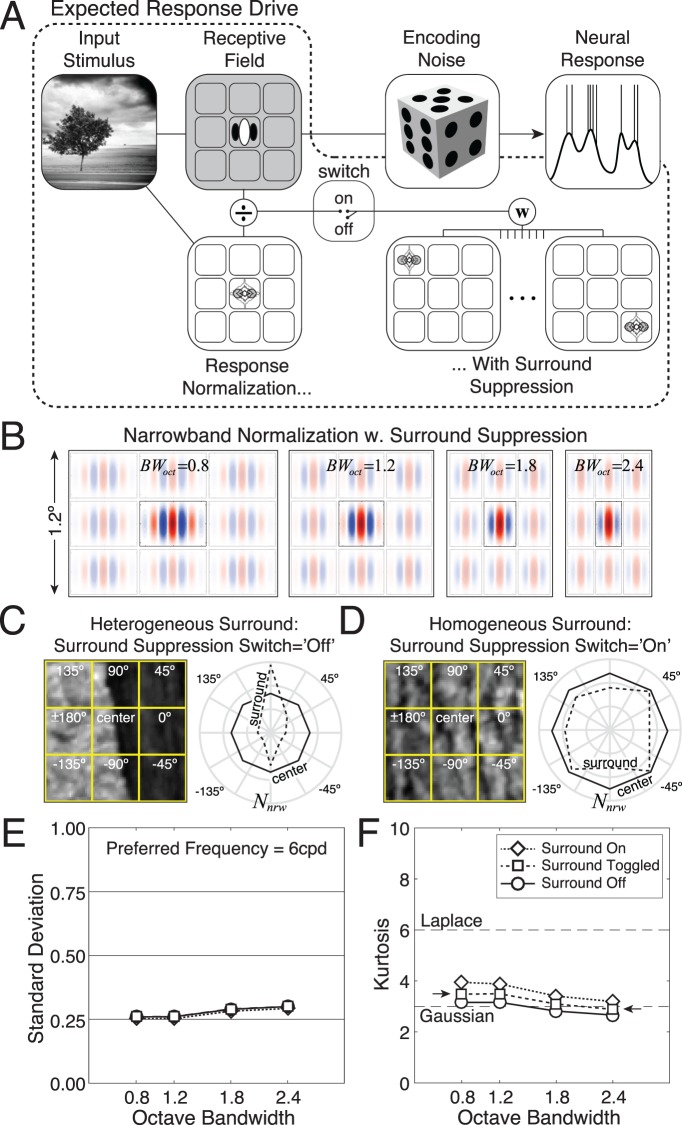
The effect of surround suppression on expected response drive. (A) Encoding model with surround suppression. The output of the linear filter is normalized by a normalization factor that is computed from the image region corresponding to the classical receptive field alone or in combination with surround suppression computed from the image region outside the classical receptive field. A narrowband normalization factor is computed in each of nine local image regions: eight from the surround and one from the center, corresponding to the preferred feature itself. Surround suppression is engaged (switch = on) if the surround is homogenous and disengaged (switch = off) if the surround is heterogeneous. (B) Spatial arrangement of classical receptive field (saturated colors) and surround (unsaturated colors). Examples with different octave bandwidths are shown. When surround suppression is engaged, the surround provides an equal contribution to the normalization factor as the image region spanned by the classical receptive field. (C) Example image with heterogeneous surround. The polar plot shows the narrowband normalization factors computed from each location in the surround (dashed curve) and from the center (solid curve). (D) Example image with homogeneous surround. (E) Standard deviation of expected response drive versus octave bandwidth with surround suppression on (diamonds), toggled (squares), and off (circles). (F) Kurtosis of expected response drive versus octave bandwidth with surround suppression on (diamonds), toggled (squares), and off (circles). Arrows mark the model most similar to that of Coen-Cagli, Kohn, and Schwartz (2015). Results are presented for a preferred spatial frequency of 6 c/°, and generalize to all spatial frequencies. Data with surround suppression off in (E–F) are identical to the data shown in Figure 8D–8E. Surround suppression causes a subtle but systematic increase on response kurtosis.